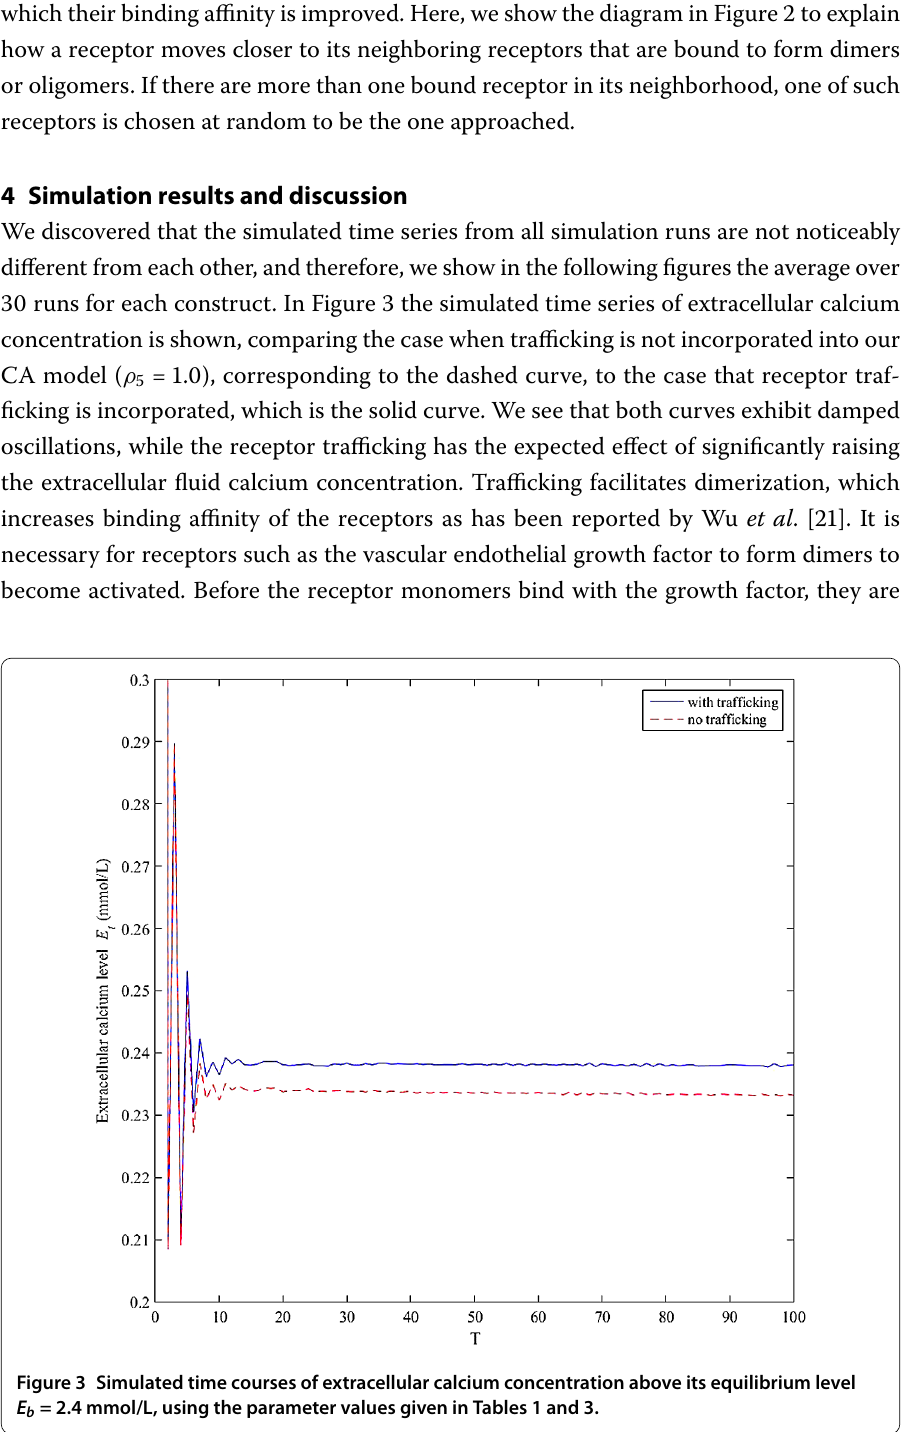
b = 2.4 mmol/L, using the parameter values given in Tables 1 and